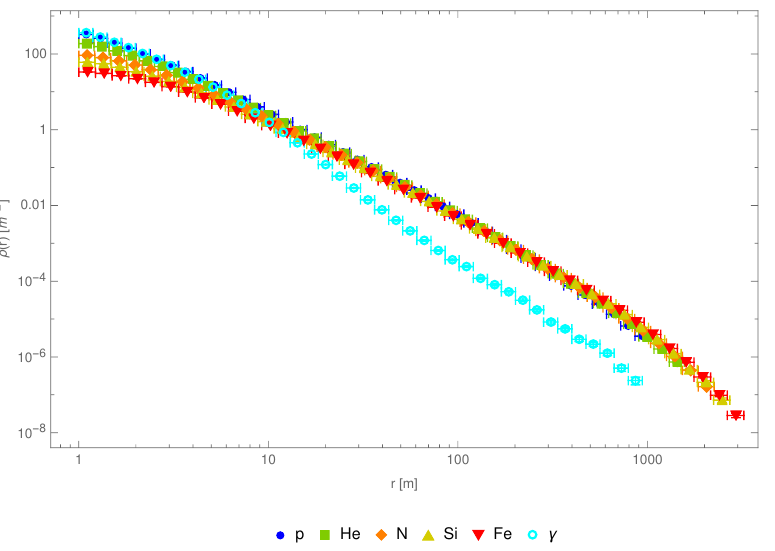
Figure 7. ρ ( r ) distribution of electrons/positrons in cascades initiated by different primary cosmic-ray particles with energy E = 4000